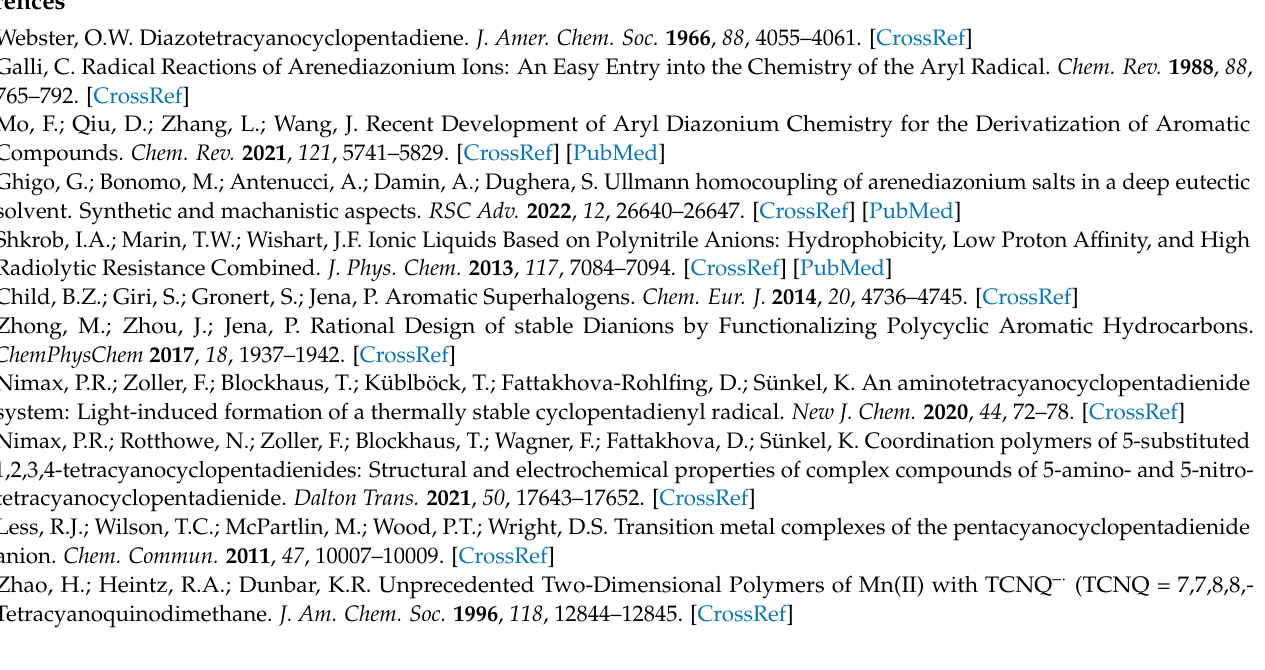
Figure S9: 13 C{ 1 H}-NMR spectrum (101 MHz, DMSO-d 6 ) of the purified product of reaction 4.6; Figure S10: The infinite 1D chain in the structure of compound 1 ; Figure S11: ORTEP 3 plot of the asym- metric unit of 4 , at r.t; Figure S12: Two views of the pore structure of 4 , generated by virtual removing the disordered toluenes; Figure S13: Two packing views of compound 4 ; Figure S14: ORTEP 3 view of the zig-zag chain of face-fused KN 4 O 2 octahedra along the x direction; Figure S15: Packing plots of compound 6 , watched along c ; Figure S16: Packing plot of compound 6 , watched along b ; Figure S17: HOMO and LUMO of compound 1 , as calculated with CrystalExplorer ; Figure S18: Electron density plot of compound 1 ; Figure S19: Two views of the electrostatic potential distribution in compound 1